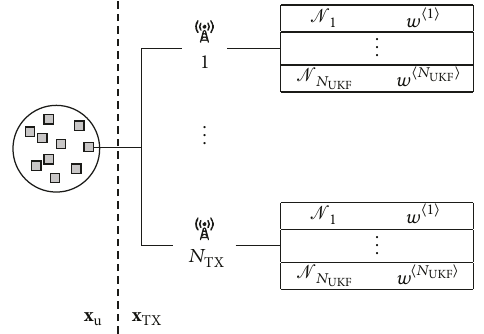
Figure 4: Structure of the RBGSPF representation: the user state x is represented by a number of particles. Each particle estimates the transmitters’ states on its own. Each of the 𝑁 is represented by a sum of 𝑁 associated weights 𝑤 ⟨ℓ⟩